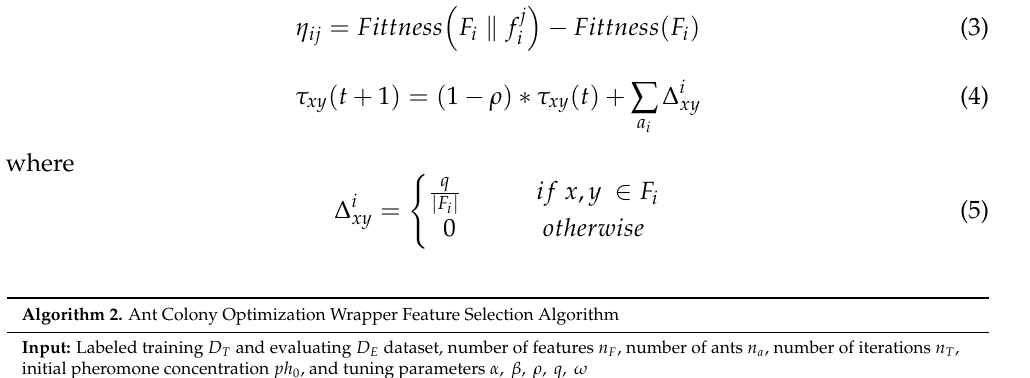
Algorithm 2. Ant Colony Optimization Wrapper Feature Selection